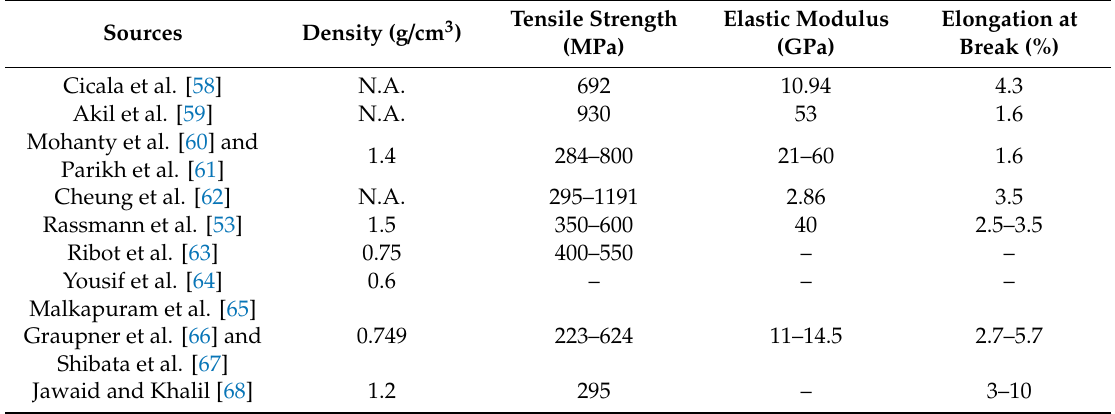
Table 3. Engineering properties of kenaf fiber